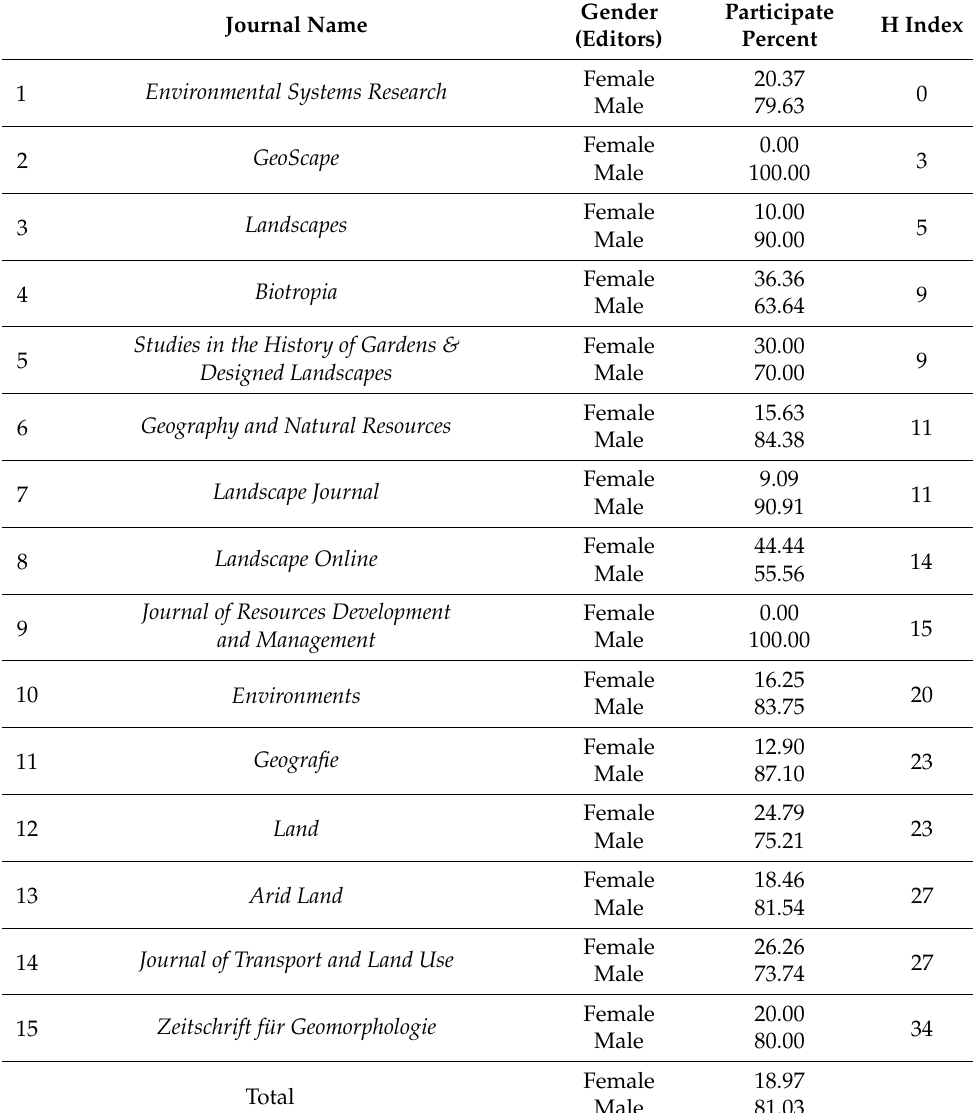
Table 2. Comparing gender contributions in low-ranking